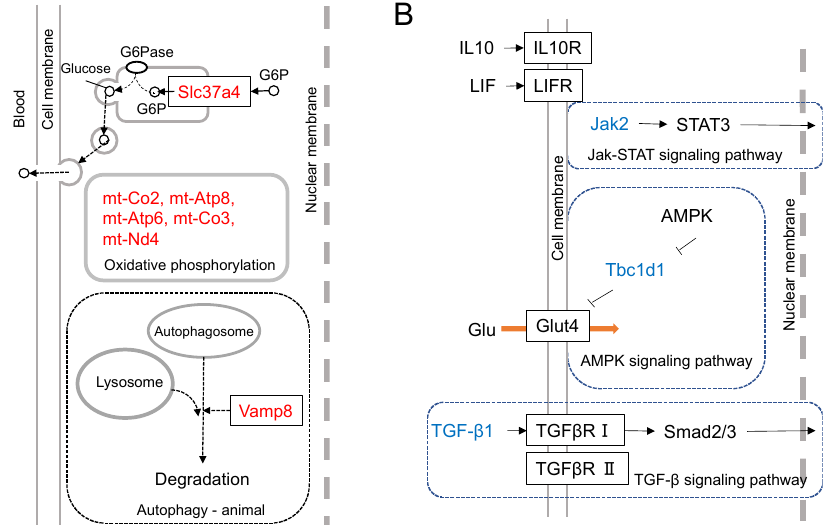
Figure 3. Results of transcriptome analysis. ( A ) Differential expression of Nanog -dependent genes between Nanog + BL6 and B16-BL6 cell lines. Assumed-role diagrams of up-regulated top-7 genes ( Slc37a4 , mt-Atp6 , mt-Nd3 , mt-Co3 , mt-Atp8 , mt-Co2 , and Vamp8 ). ( B ) Differential expression of Nanog -dependent genes between Nanog + BL6 and B16-BL6 cell lines. Assumed-role diagrams of down-regulated top-3 genes ( Jak2 , Tbc1d1 , and TGF- β 1 ).